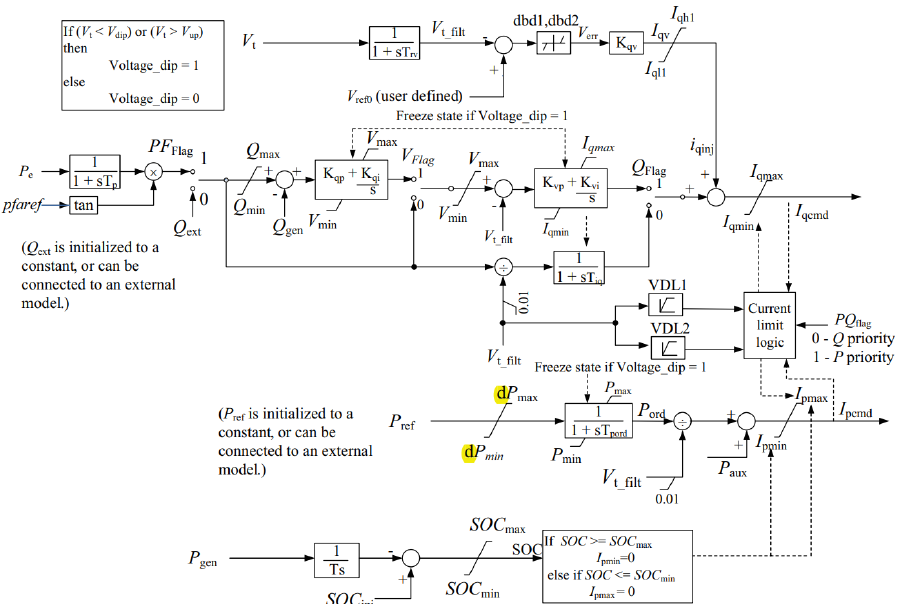
Figure 3. The REEC module control block diagram of a universal model of energy storage systems. Reprinted from Ref. [4] (Fig. 12), 2016, Xiaokang Xu. Table 2. Parameters of the REEC module. No.